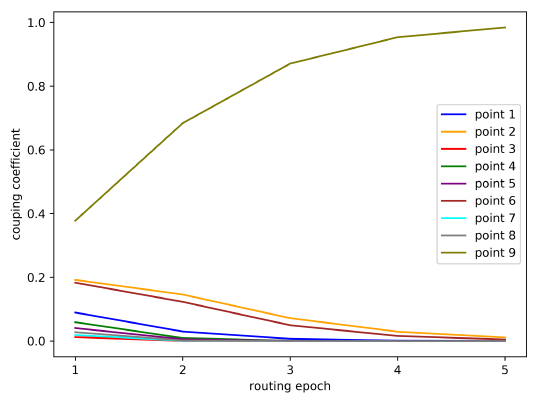
Figure 11. A demo in which nine points runs dynamic routing algorithm for prototype